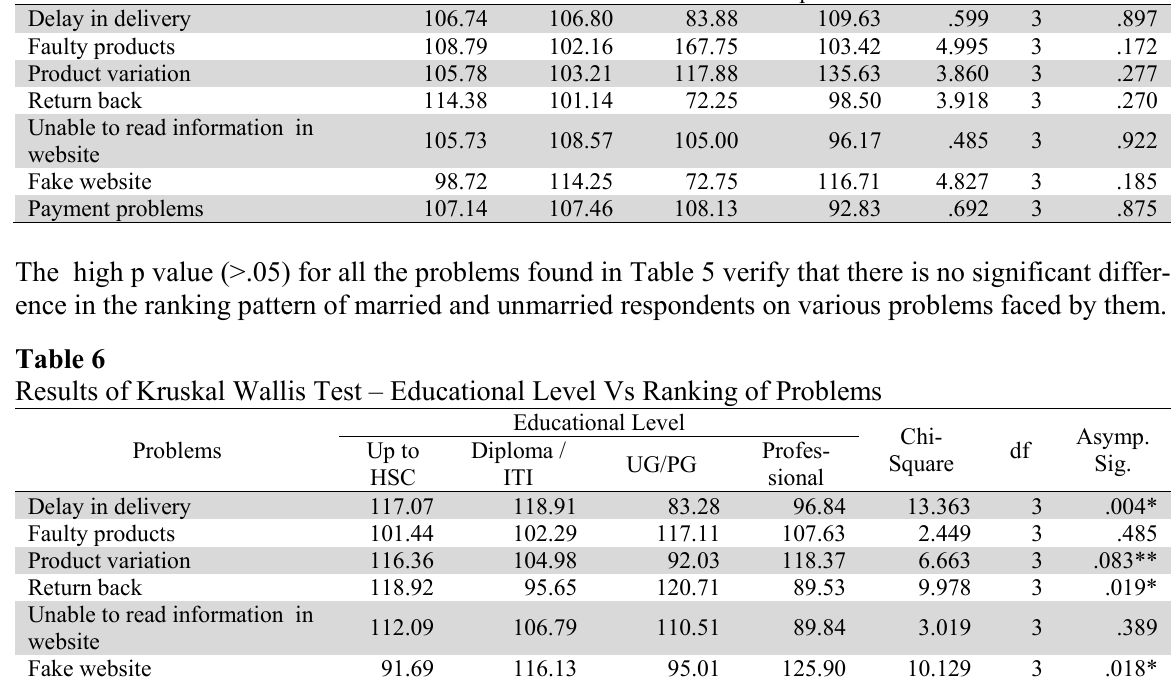
Results of Kruskal Wallis Test – Marital Status Vs Ranking of Problems Problems